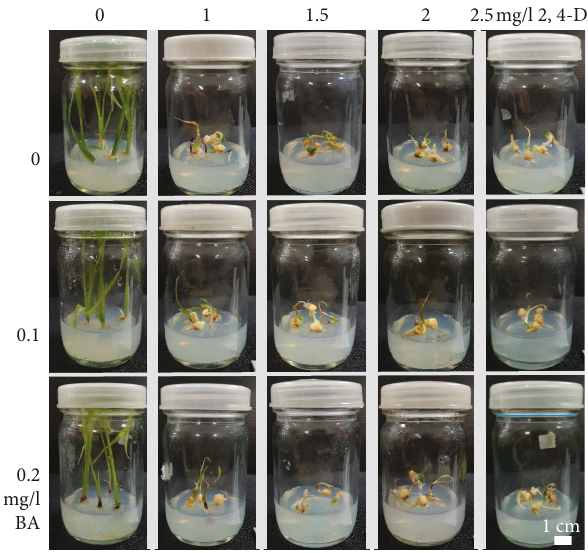
Figure 1: Callus observations of Luem Pua seed cultures on MS medium containing various concentrations of BA and 2,4-D for three